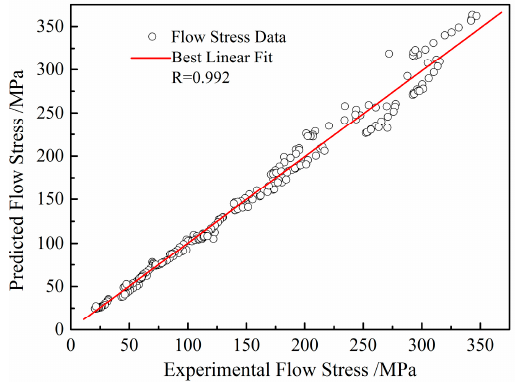
Figure 13. Correlation between the experimental and calculated flow stress data.